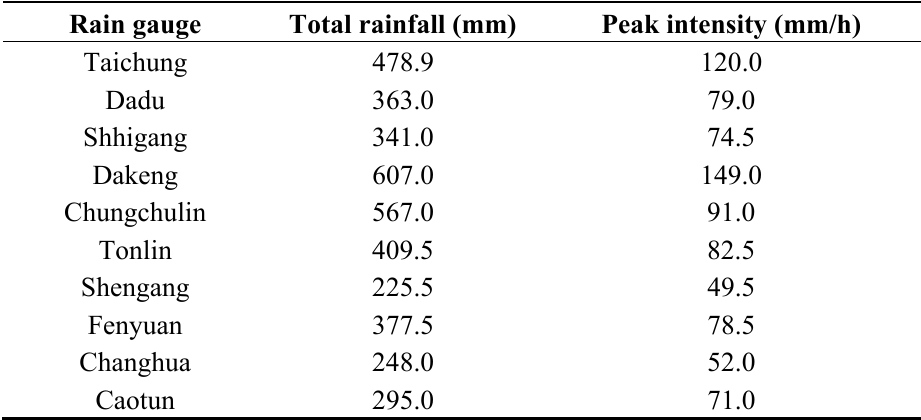
Table 5. Total amount and peak intensity of rainfall of Typhoon Kalmaegi in Taichung City.